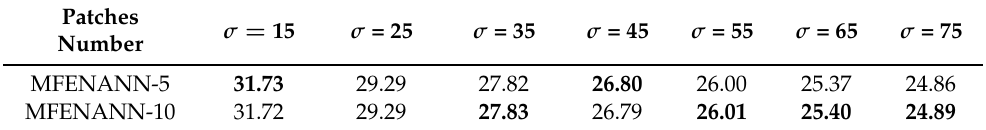
Table 3. Average PSNR (dB) values for images in “BSD68” restored by MFENANN which were trained with patch numbers of 577 × 10 3 and 1 × 10 6 . The bold numbers are the largest ones at each corresponding noise